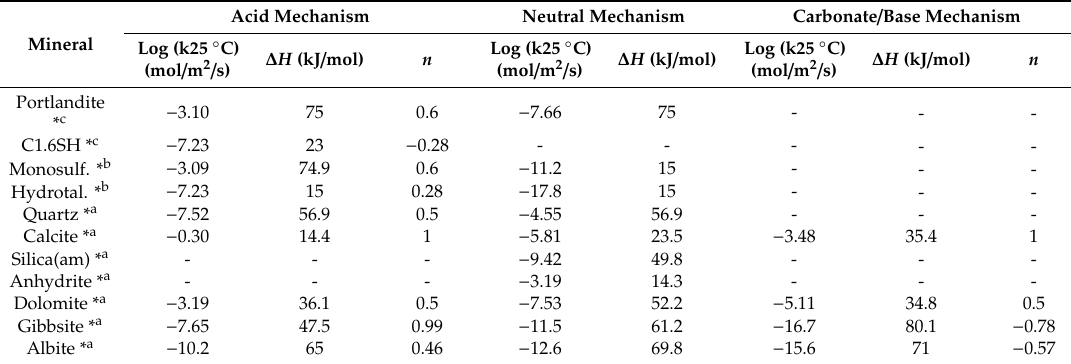
Table 3. Kinetic rate parameters (* a [32], * b [33] and * c [34]).